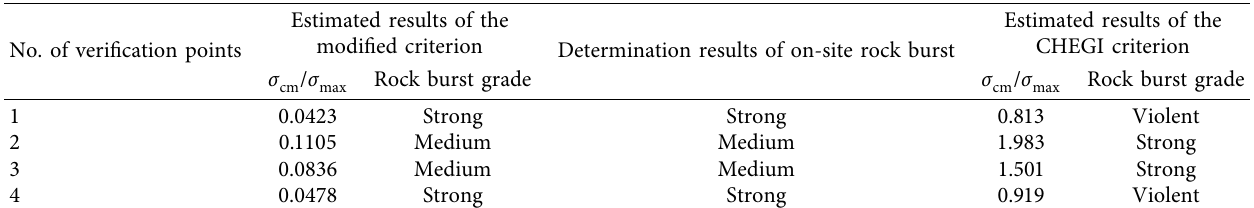
Table 11: Comparison of rock burst estimation results between the CHEGI and modified